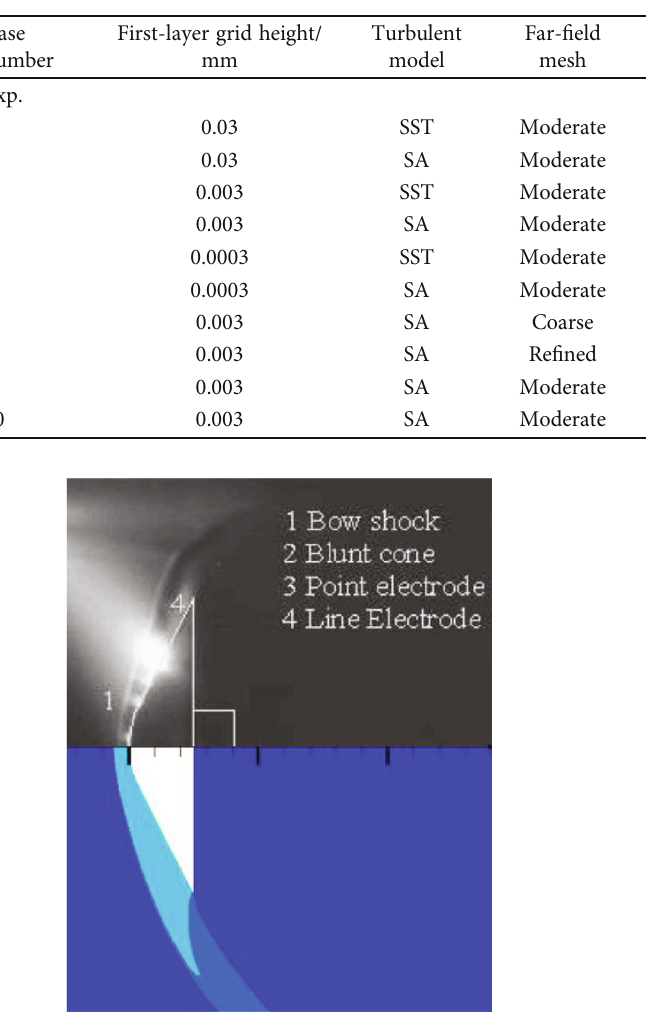
Figure 4: Experimental model. Table 4: Comparison of drag coe ffi cients between numerical simulation and experiment.